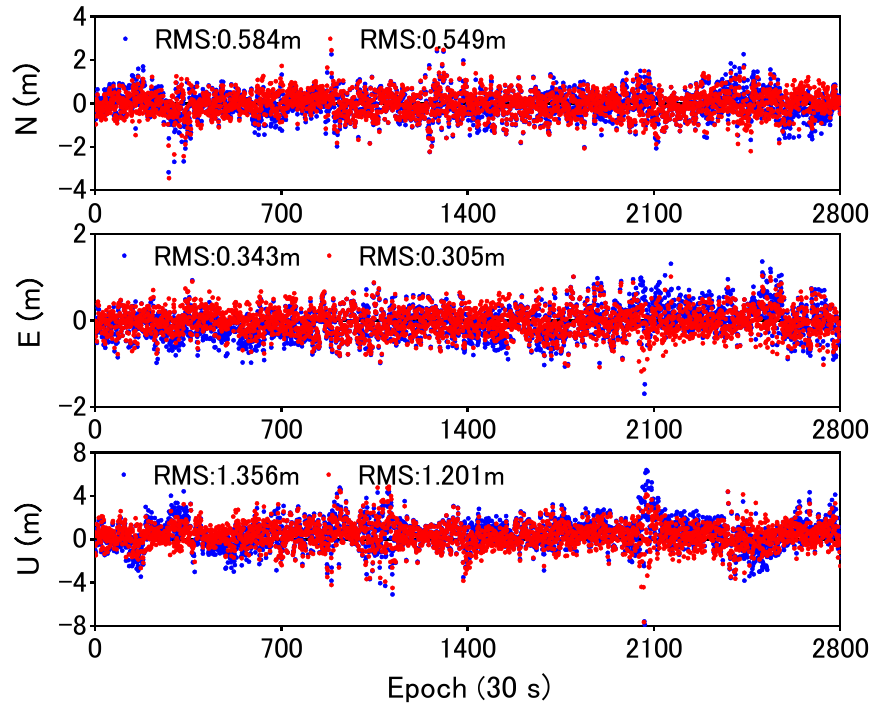
Figure 6. Positioning errors of combined GPS/Galileo/BDS relative positioning using short baseline MAR6_MAR7 on DOY 101, 2019, without ( blue ) and with ( red ) receiver-related pseudorange biases correction.